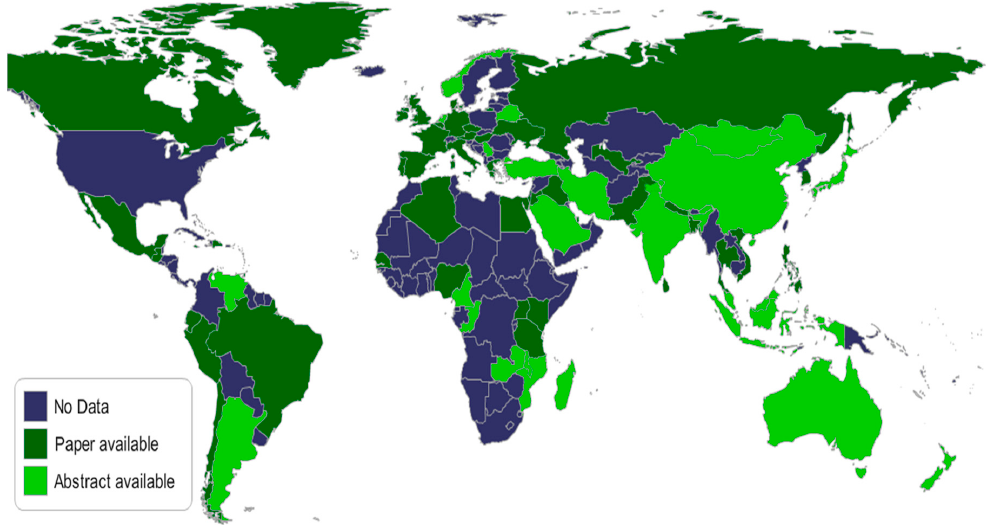
Figure 1. A map showing completed country estimates of fungal diseases by August 2017.